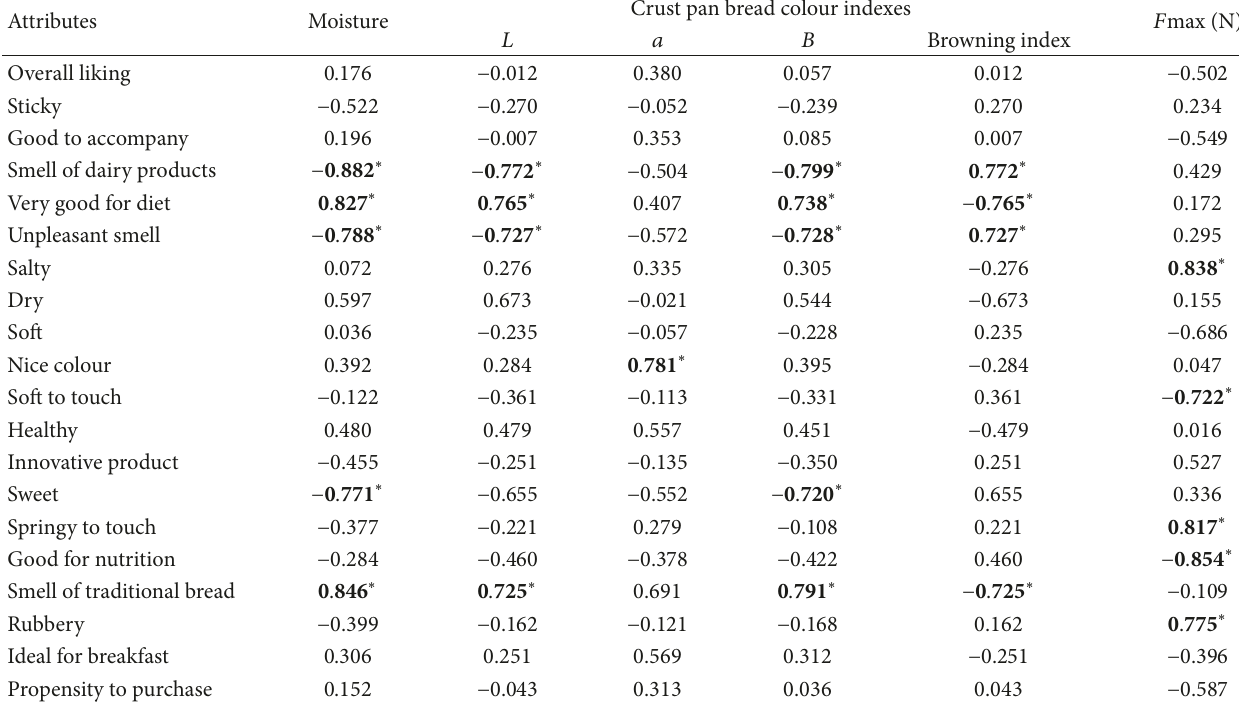
Table 6: Pearson’s correlation between textural data and CATA